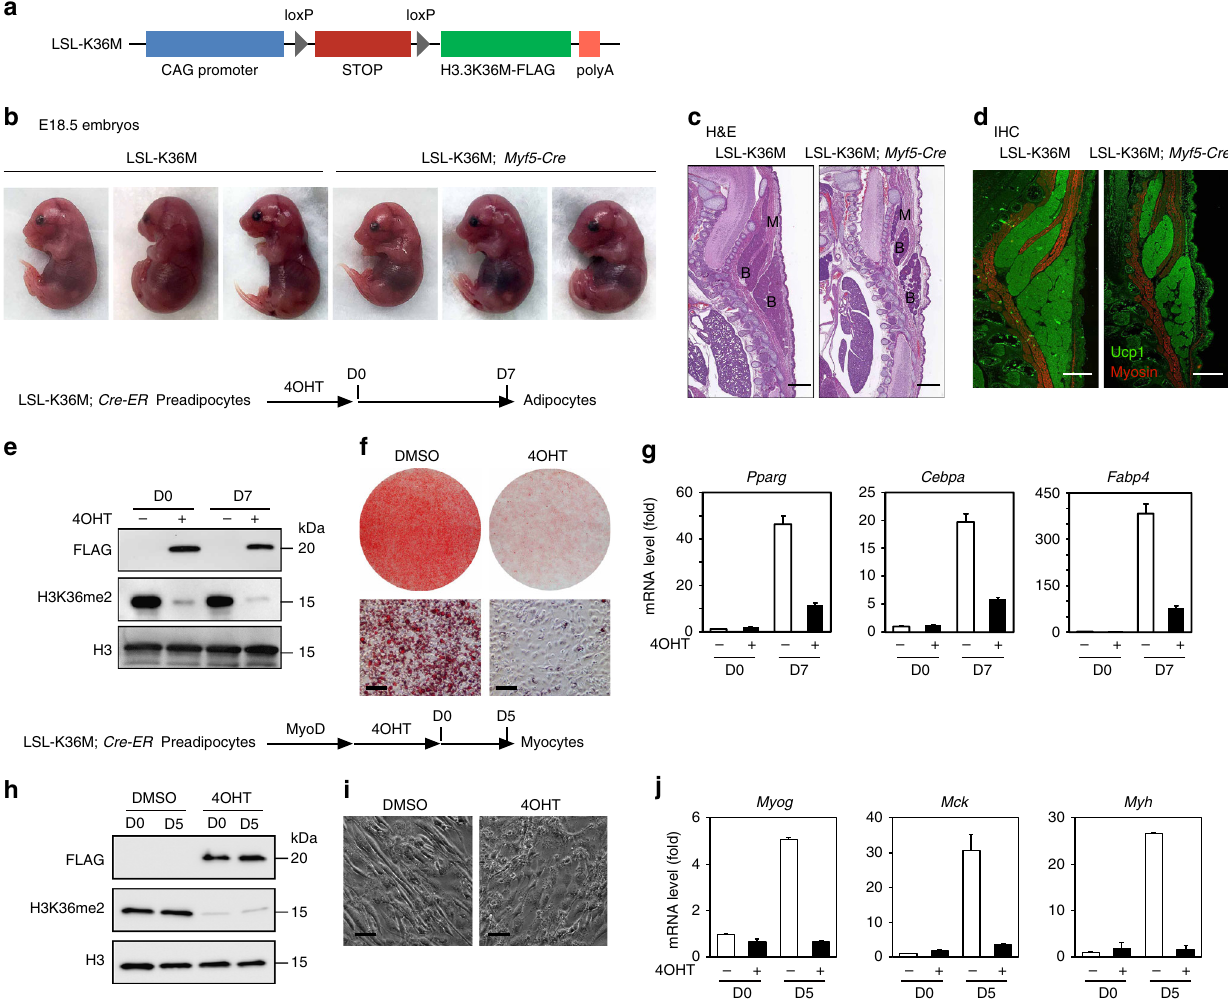
Fig. 4 Expression of H3.3K36M in Myf5 + progenitor cells impairs brown adipose tissue and muscle development. a Schematic of the LSL-K36M transgenic construct. The LSL-K36M transgene consists of the following elements from 5 ′ to 3 ′ : CAG promoter, four copies of SV40 stop signals (STOP) fl anked by two loxP sites, H3.3K36M with FLAG tag, and polyA. b – d LSL-K36M were crossed with Myf5-Cre to generate LSL-K36M; Myf5-Cre mice expressing H3.3K36M in progenitor cells of brown adipose tissue (BAT) and muscle. b Representative morphology of E18.5 embryos. c , d Histological analysis of E18.5 embryos. Sagittal sections of cervical/thoracic area were stained with H&E ( c ), or with antibodies against the BAT (B) marker Ucp1 (green) and the muscle (M) marker Myosin (red) ( d ). Scale bar = 300 µ m. e – g LSL-K36M were crossed with Cre-ER to generate LSL-K36M; Cre-ER mice. Primary brown preadipocytes were isolated from newborn pups. After SV40T immortalization, cells were treated with 4-hydroxytamoxifen (4OHT) to induce H3.3K36M expression, followed by adipogenesis assay. e Western blot in LSL-K36M; Cre-ER preadipocytes (D0) and adipocytes (D7). f Oil Red O staining at D7 of adipogenesis. Scale bars = 30 μ m. g qRT-PCR of Pparg , Cebpa , and Fabp4 expression at D0 and D7 of adipogenesis. h – j Immortalized LSL-K36M; Cre-ER preadipocytes were infected with retroviral vector expressing MyoD. After puromycin selection, cells were treated with 4OHT to induce H3.3K36M expression, followed by myogenesis assay. h Western blot in LSL-K36M; Cre-ER preadipocytes (day 0, D0) and myocytes (day 5, D5). i Cell